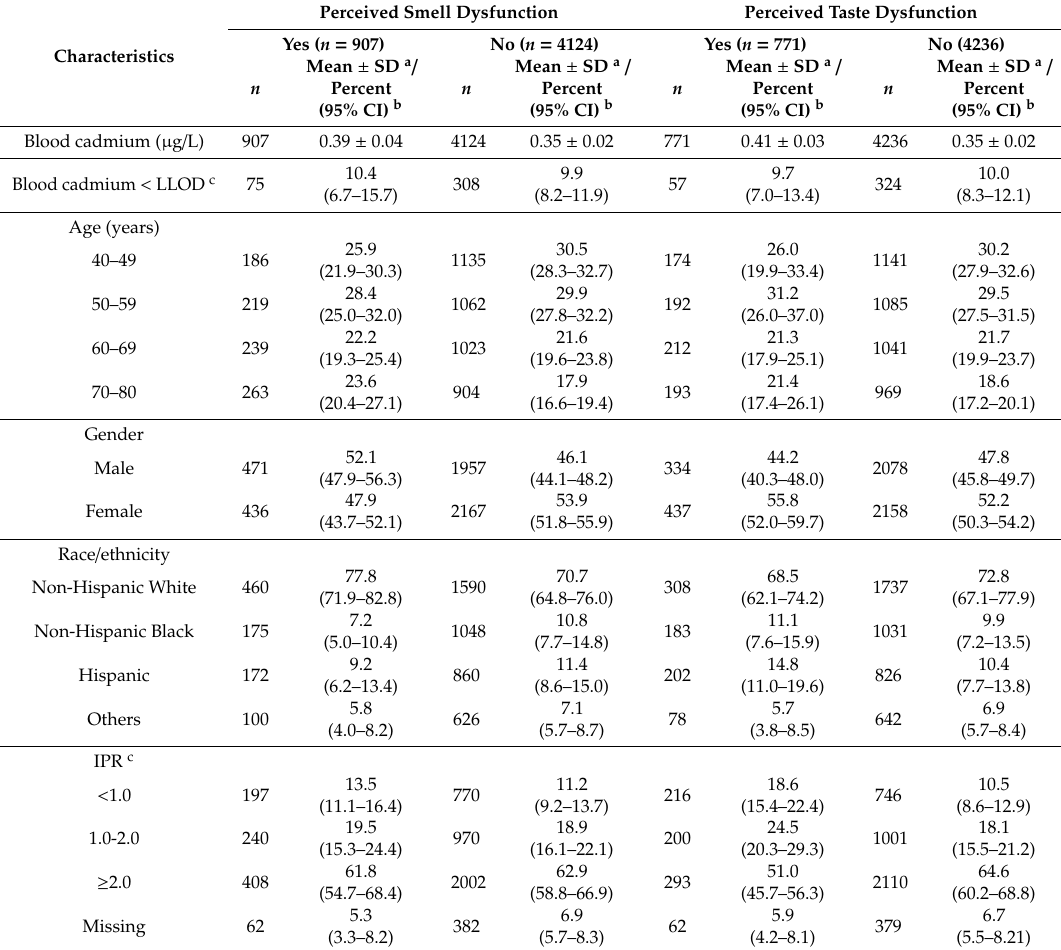
Table 1. Distributions of characteristics by perceived taste and smell dysfunction among adults in